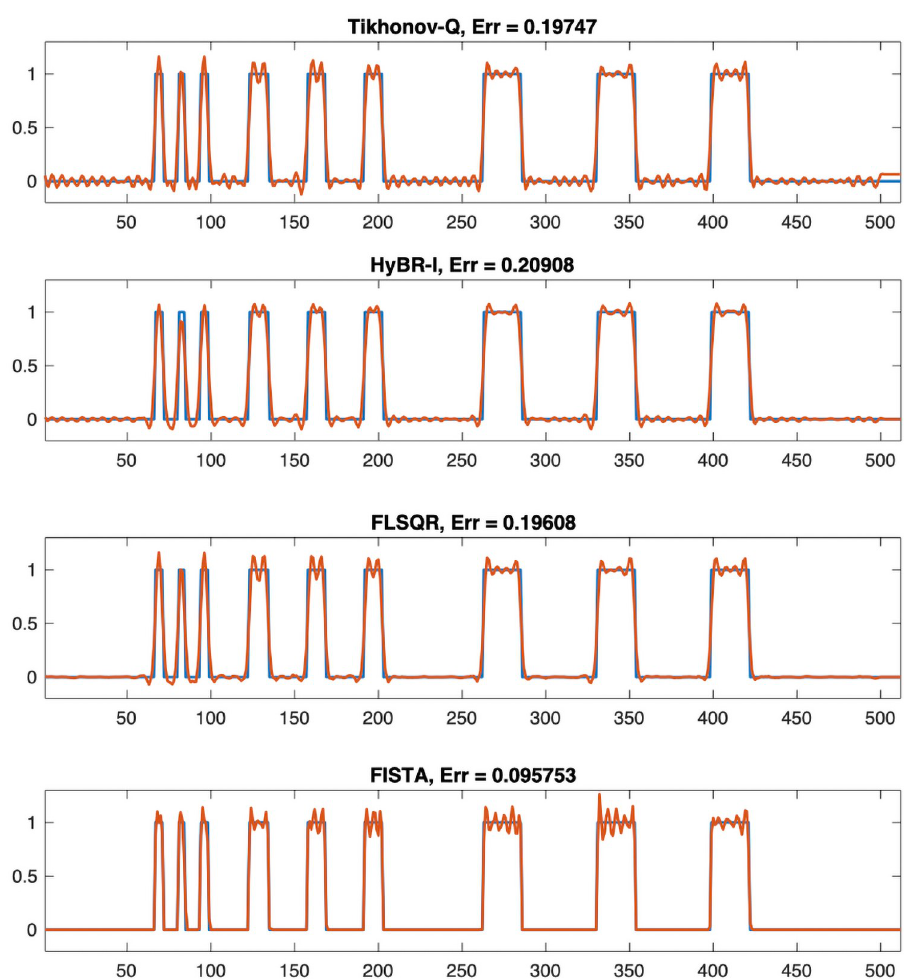
Fig 5. Reconstructions for linear respirometry reconstruction. Tikhonov- Q and HyBR-I reconstructions correspond to ℓ 2 regularization, and FLSQR-R and FISTA reconstructions correspond to ℓ 1 regularization. The true signal is provided in the blue line and the reconstructions are provided in red. Relative reconstruction error norms computed using the 2-norm are provided in the titles.